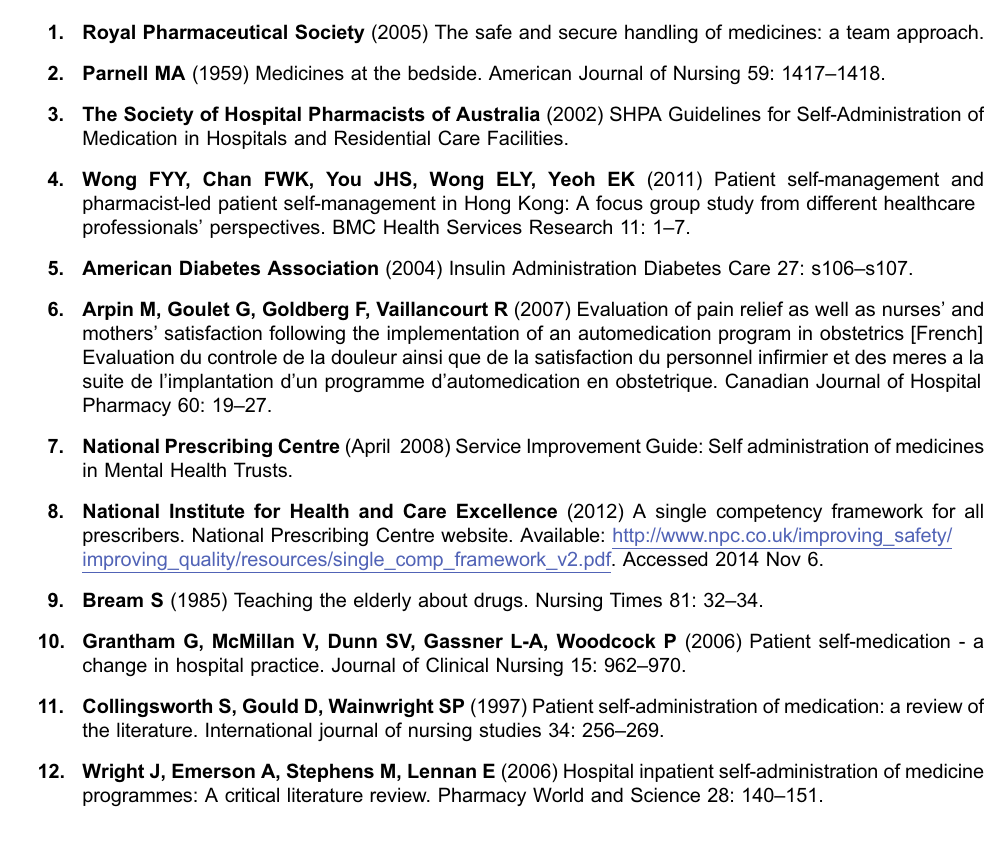
Table S3. Study outcomes and results by